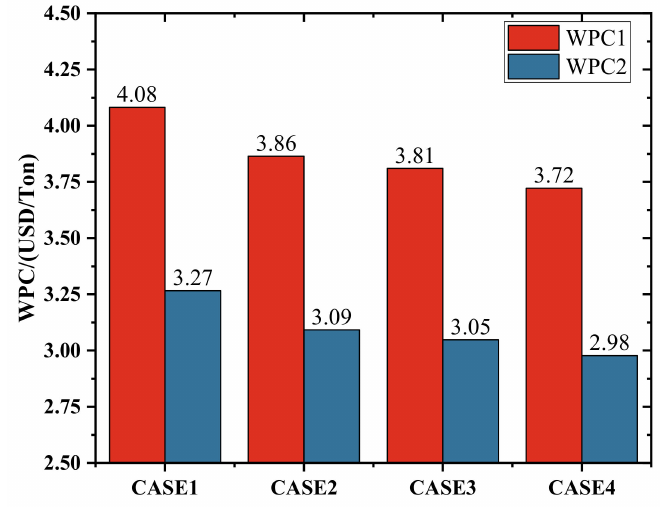
Figure 13. WPC1 and WPC2 under different arrangements of